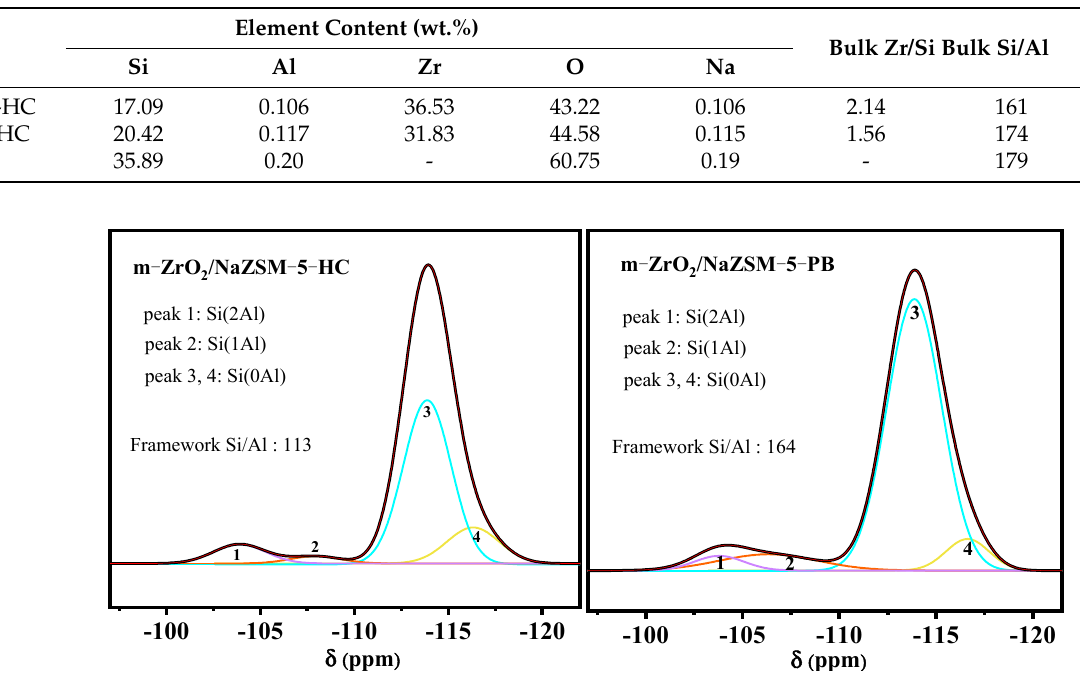
Table 1. Elemental composition of different catalysts.